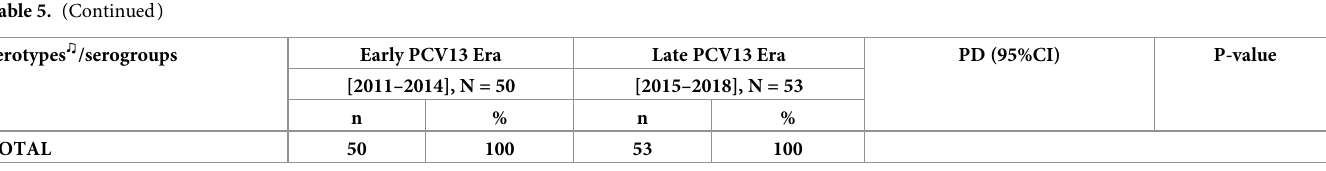
Table 6. Comparison of some epidemiological characteristics between the ’early and late post-PCV13 impact peri- ods of 2–59 months old children with laboratory-confirmed pneumococcal meningitis hospitalized at the sentinel surveillance hospitals in Yaounde´: 2011—2018 (N = 103).